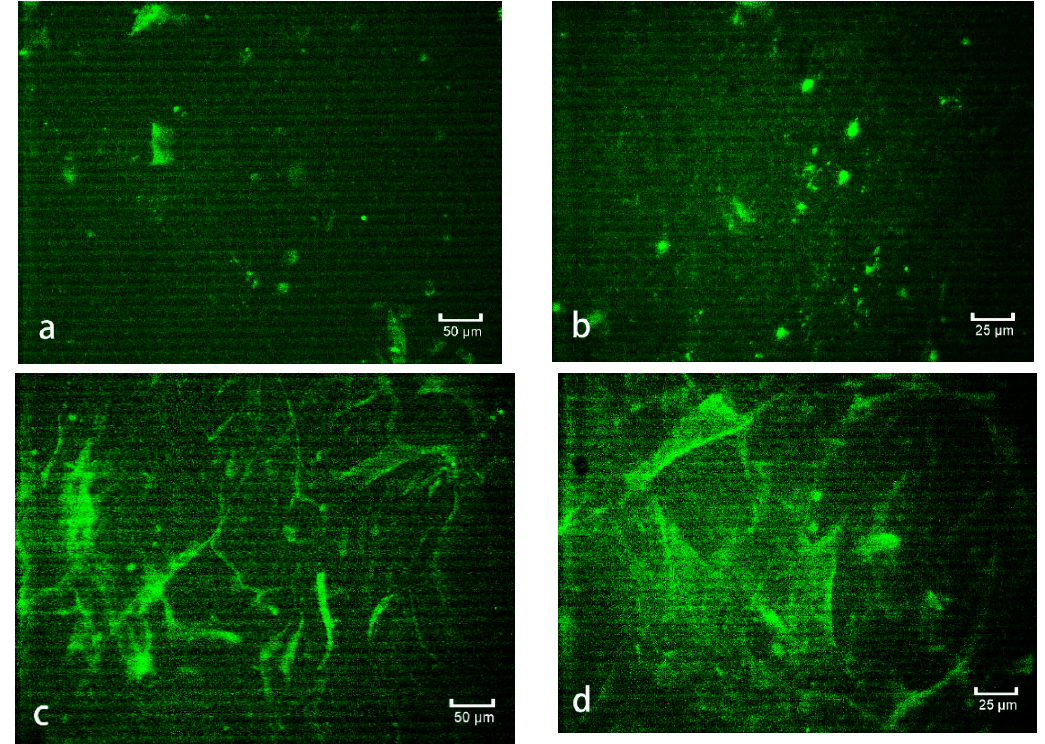
Figure 11. FM of SBS at 20 × 20 times ( a ) and 20 × 40 times ( b ), and SBS-g-GOs (0.04%) at 20 × 20 times ( c ) and 20 × 40 times ( d ).